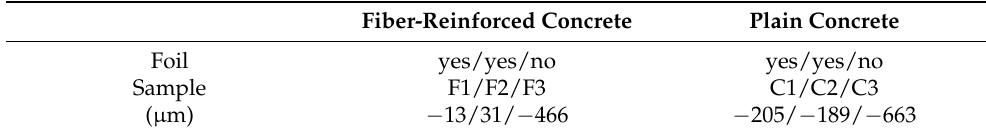
Table 6. Total volume changes—shrinkage. Time: 42 days.